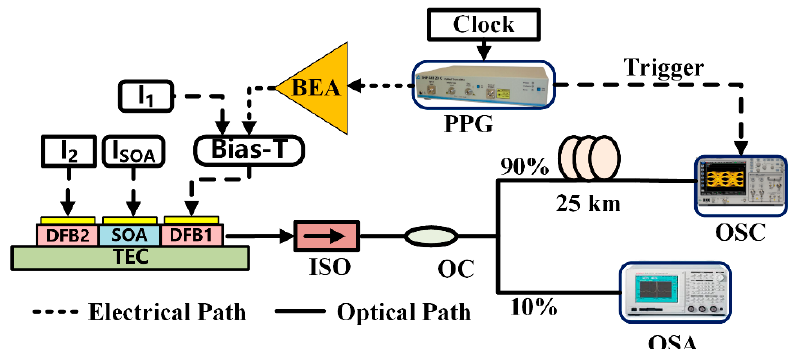
Figure 9. Experimental setup for the eye diagram. PPG: pulse pattern generator; BEA: broadband electrical amplifier; ISO: isolator; OC: optical coupler; OSA: optical spectrum analyzer; OSC: oscilloscope; TEC: thermoelectric cooler.